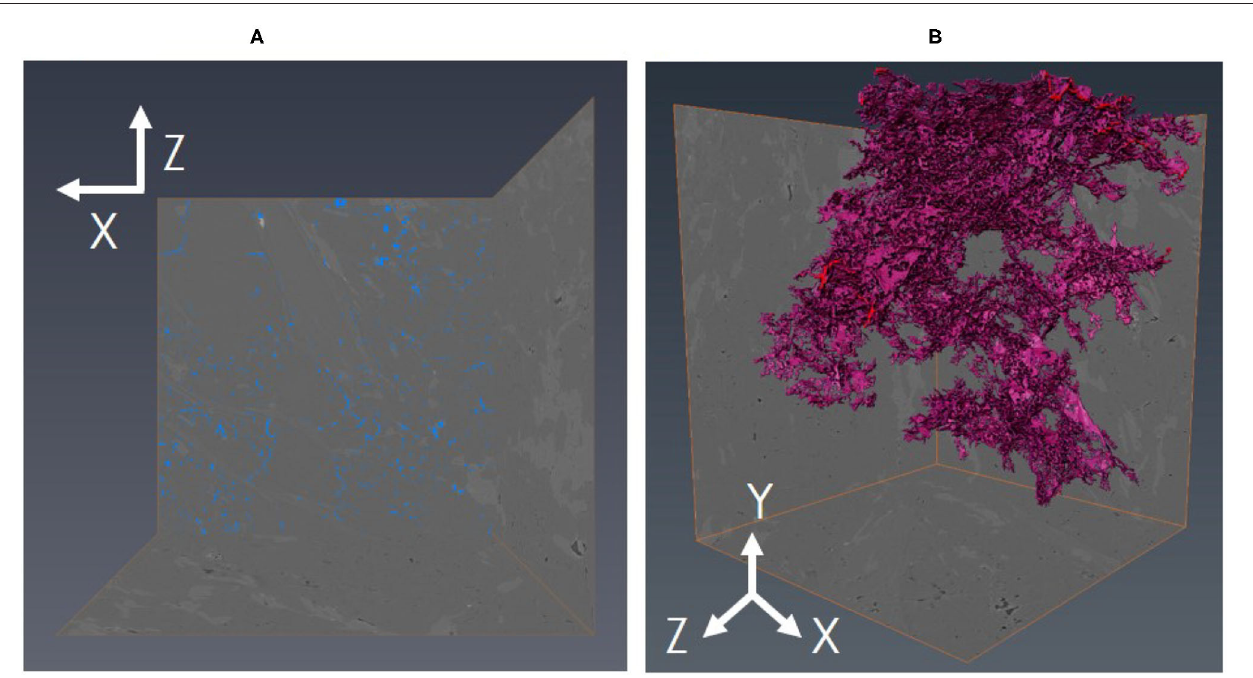
FIGURE 4 | (A) An example of pore segmentation (blue) on a 2D micro-CT slice for a mylonite. (B) The connected 3D pore network (pink) in the sample. The size of the cubic sub-volume of the micro-CT data analyzed and shown here is 470 X 400 X 400 µ m 3 .